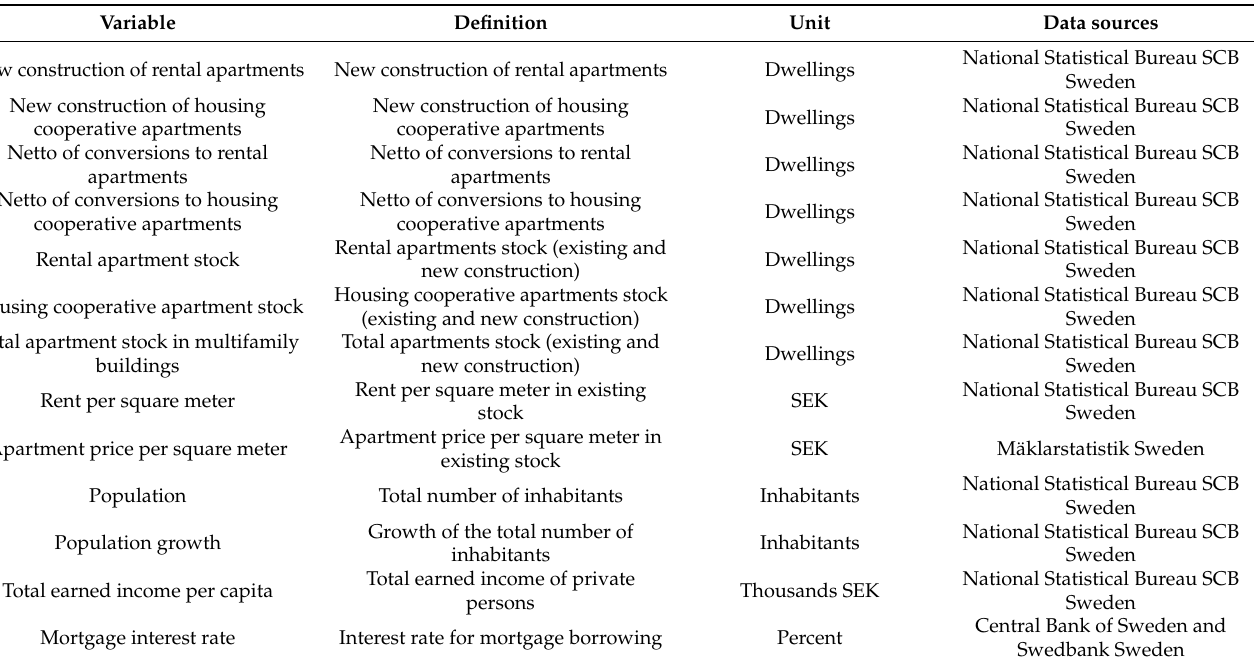
Table A2. Variables definitions and data